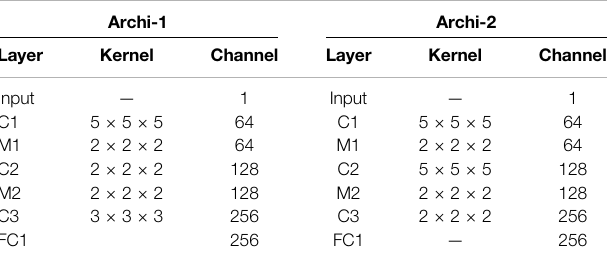
TABLE 1 | Architecture of the multilevel contextual 3D